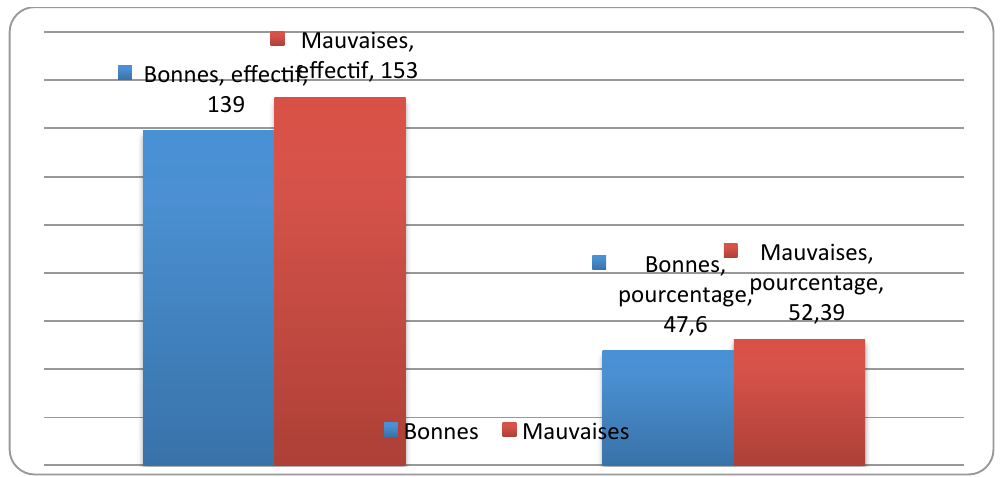
Figure 5. Conditions de logement à la cité GCM -